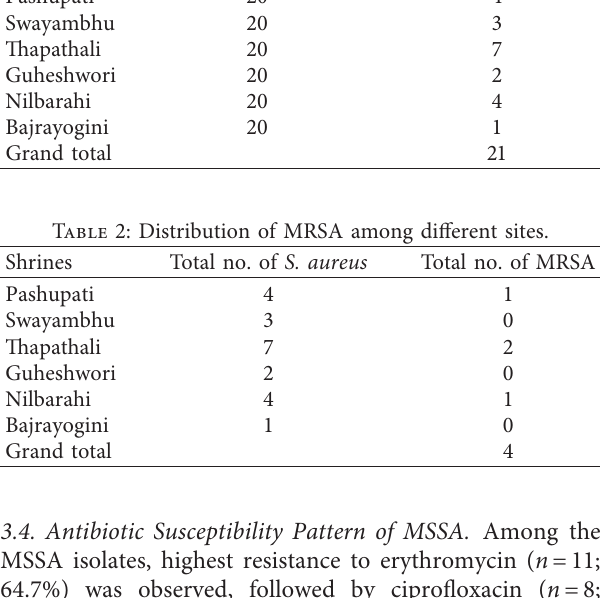
Table 1: Distribution of S. aureus among different sites. Shrines Total no. of samples Total no. of S. aureus